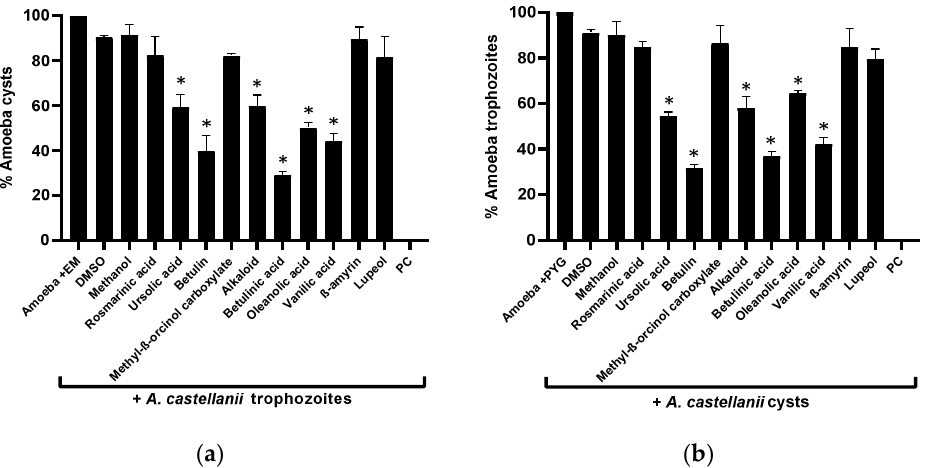
Figure 4. Effects of isolated compounds on the encystation and excystation of A. castellanii . The results revealed that compounds inhibited both encystment and excystment processes in A. castellanii , compared with the negative control: ( a ) the encystation process; ( b ) the excystation effects. The data are presented as the mean ± standard error. p values were calculated using a two-sample t -test with two-tailed distribution; (*) denotes that p <